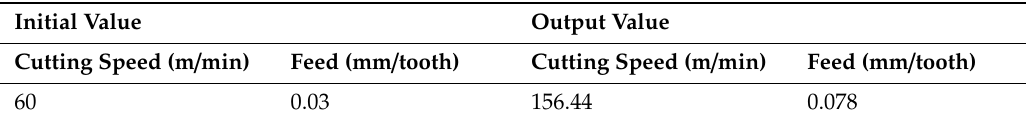
Table 5. Initial and optimum parameters of step milling.